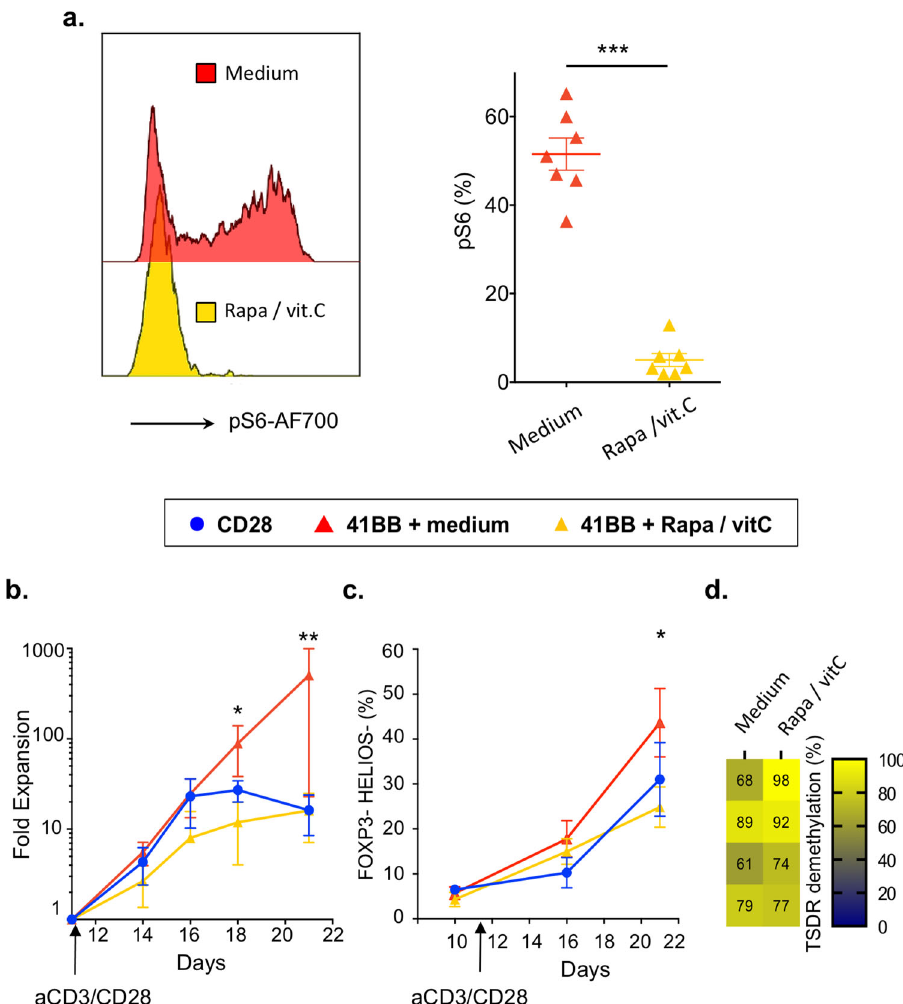
Fig. 5 The combination of rapamycin and vitamin C abates overactivation due to 4-1BB tonic signaling and improves CAR-Treg stability. a Histograms of phosphoS6 staining on day 16 of culture (left panel, representative of seven donors from seven independent experiments) and frequency comparison between 4-1BB and 4-1BB + rapamycin/vitamin C ( p = 0.0006) (right panel). b Fold expansion of CD28 or 4-1BB CAR-Tregs, cultured with or without rapamycin/vitamin C cocktail from the second anti-CD3/CD28 bead activation on day 11 (arrow) to day 21. N = 5 donors from fi ve independent experiments. Statistical signi fi cance was found when comparing 4-1BB CAR-Tregs cultured with or without Rapamycin/vitamin C, at day 18 ( p = 0.0159) and day 21 ( p = 0.0079). c Frequency of double-negative (HELIOS and FOXP3) cells on days 10, 16, and 21 of culture by fl ow cytometry. Signi fi cant difference was found between 4-1BB CAR-Tregs cultured with ( n = 9) or without ( n = 8) Rapamycin/vitamin C cocktail, at day 21 ( p = 0.0499). d Percentage of 4-1BB CAR-Tregs with Treg-speci fi c demethylated region (TSDR) demethylation on day 16 of culture with or without rapamycin and vitamin C starting on day 11, from four different donors. Blue circle, red and yellows triangle refer to CD28, 4-1 BB, and 4-1BB + rapamycin/vitamin C populations, respectively (panels a – c ). Data are depicted as mean + / − SEM (panels a and c ) or median + / − interquartile range (IQR) (panel b ) and compared using two-tailed Mann – Whitney test (* p < 0.05, ** p < 0.01, *** p < 0.001, **** p <